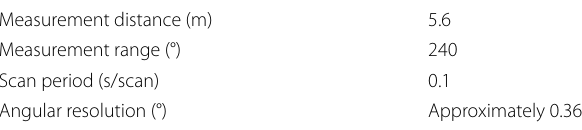
Table 2 Specifications of the